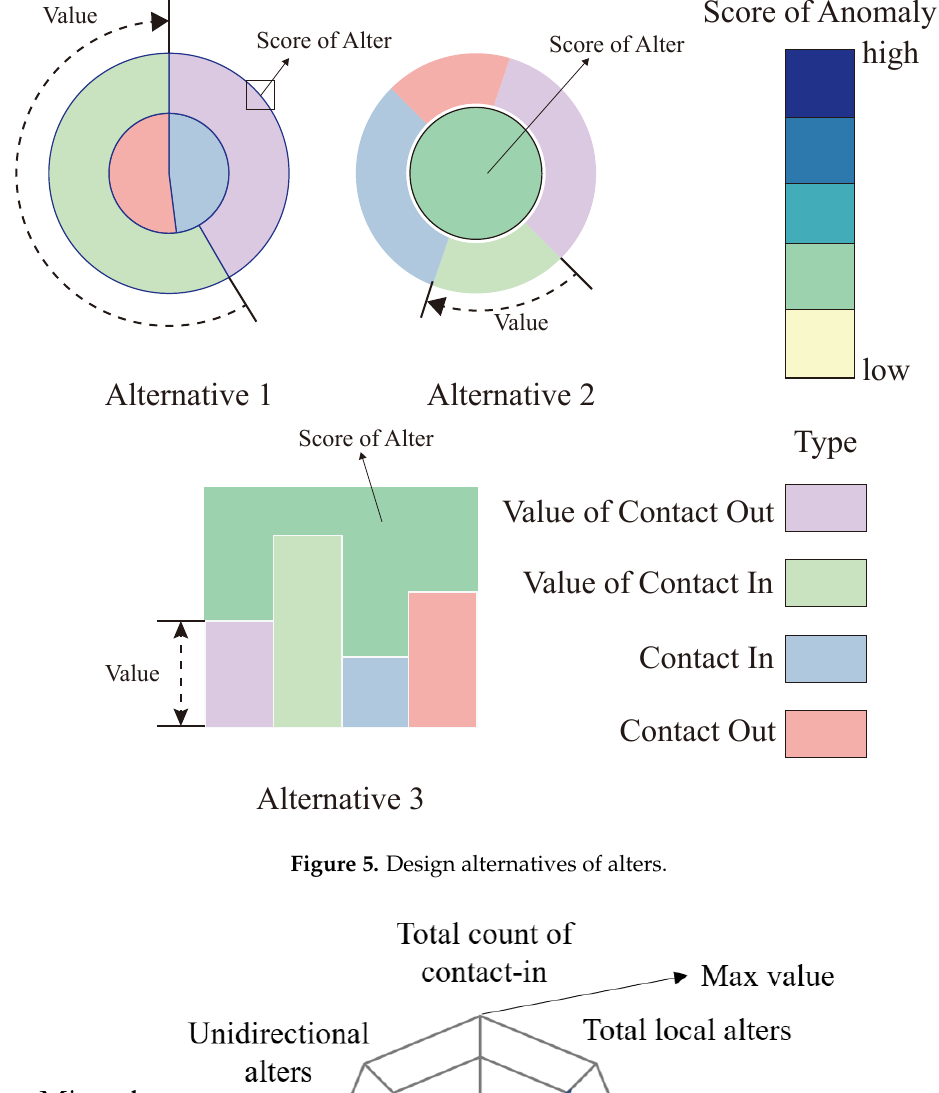
Figure 5. Design alternatives of alters.